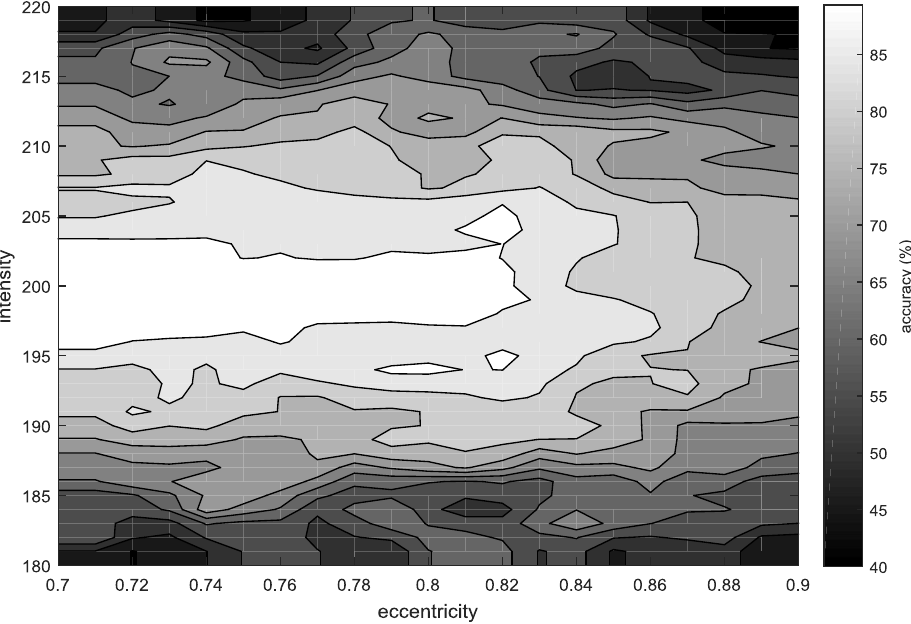
Figure 6. Fat regions detection accuracy (average for the steatosis images).